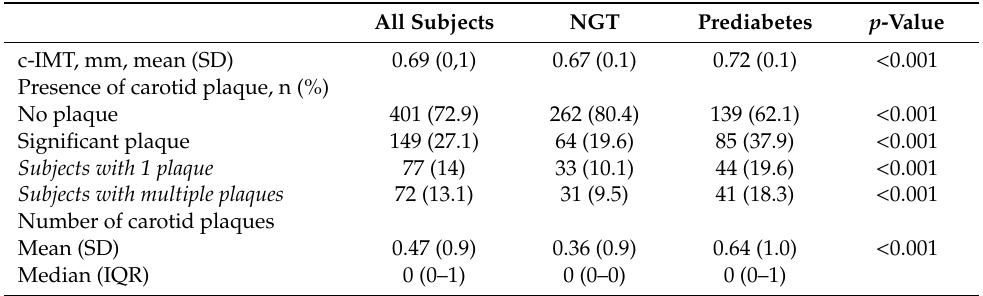
Table 2. Carotid intima-media thickness (c-IMT) and plaque burden among patients with prediabetes or normal glucose tolerance.